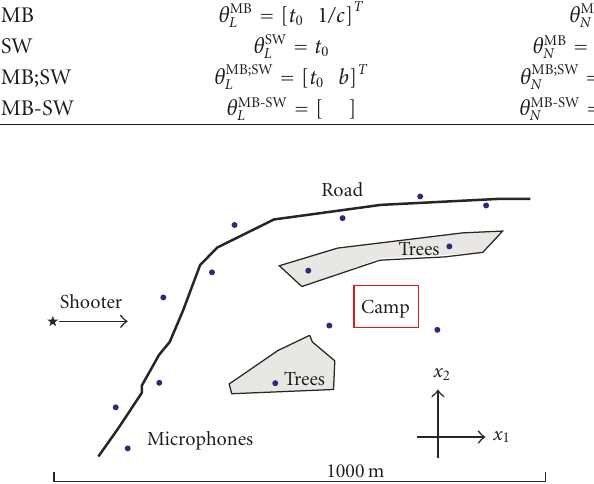
Figure 4: Example scenario. A network with 14 sensors deployed for camp protection. The sensors detect intruders, keep track on vehicle movements, and, of course, locate